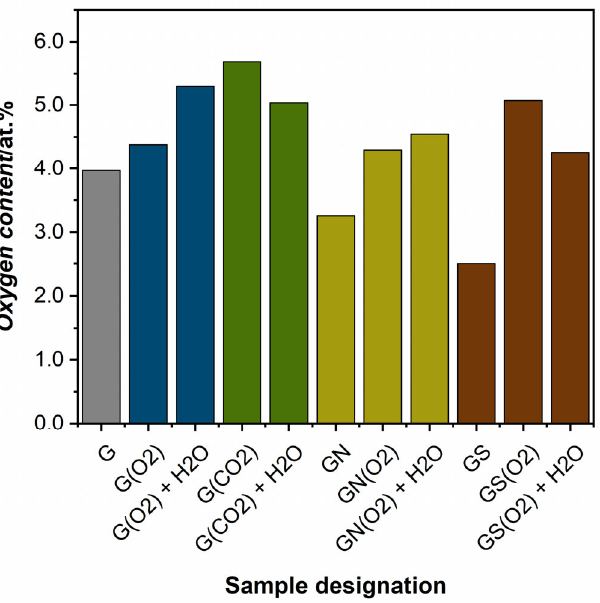
Figure 10. Oxygen content determined with XPS analysis of plasma and acid ‐ treated graphite sam ‐ ples. Legend: G—graphite reference, G(O2)—O 2 plasma ‐ treated graphite; G(O2) + H 2 O—water ‐